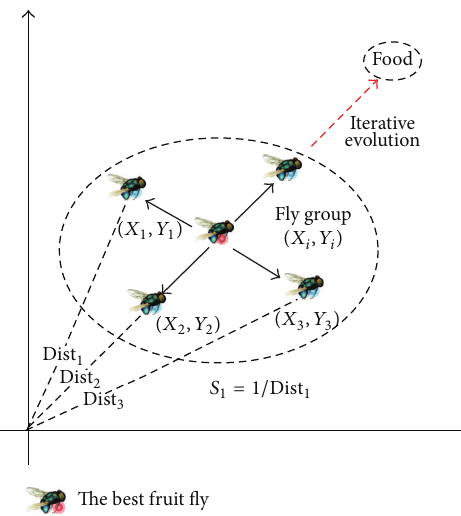
Figure 3: The process of food-seeking of a fruit fly swarm.